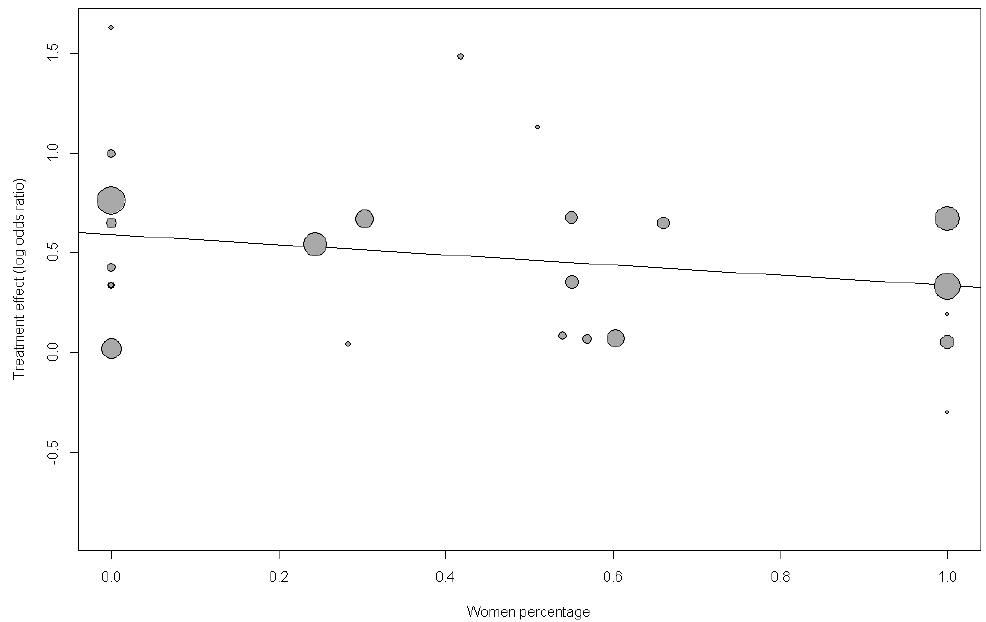
Figure 4. Meta-regression bubble plot of correlation between log odds ratio of cardiovascular disease and the proportion of women.